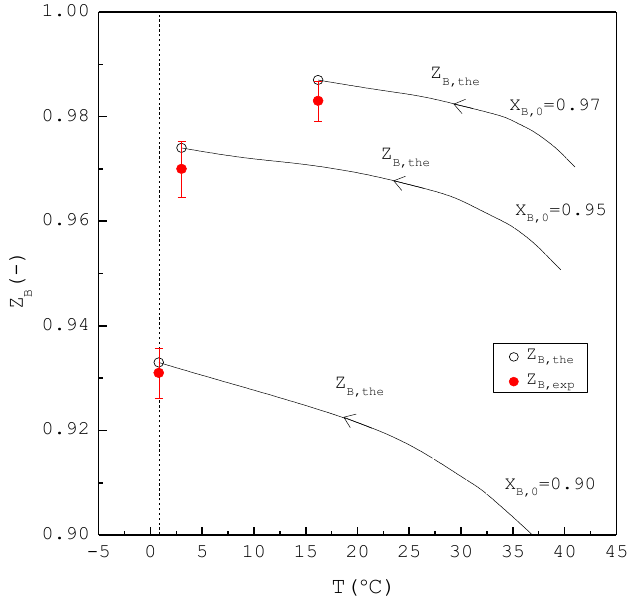
Figure 9. Comparison between Z B , exp and Z B , the of the final product for the purification of p - chlorophenol from 20 g liquid feed for each X B ,0 , where Z B , the ( T ) is plotted against the operating temperature for each X B ,0 . Each solid circle data point represents the average Z B , exp for four repetitive experiments and error bar represents the 95% confidence interval for the experimental Z B , exp .